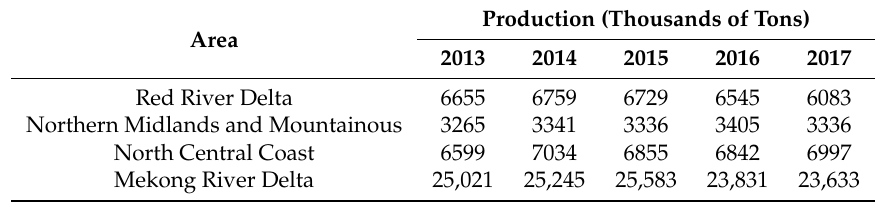
Table 1. Rice production of the four largest rice areas in Vietnam (General Statistics Office (GSO))